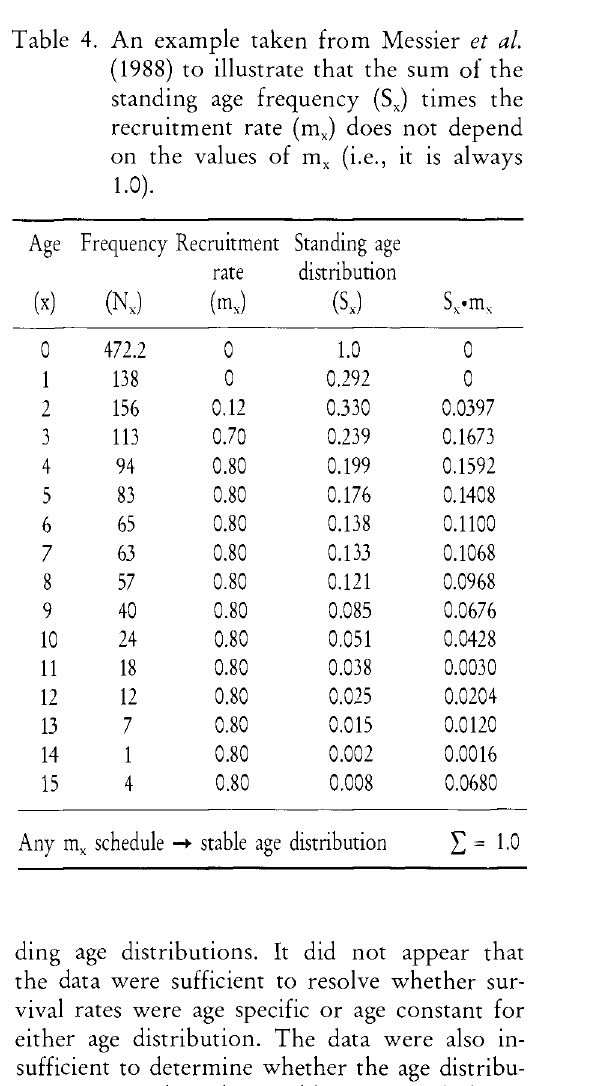
) times the x ) does not depend x (i.e., it is always x